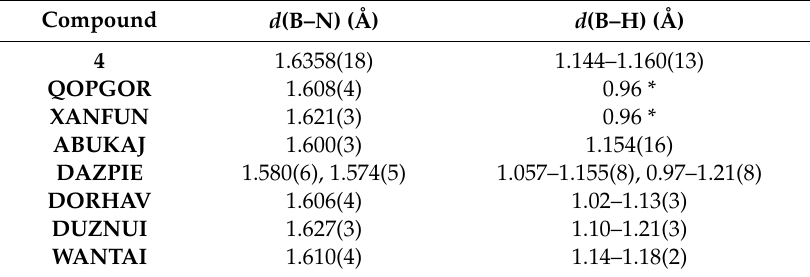
Table 2. Aminoborane group comparison with published results.